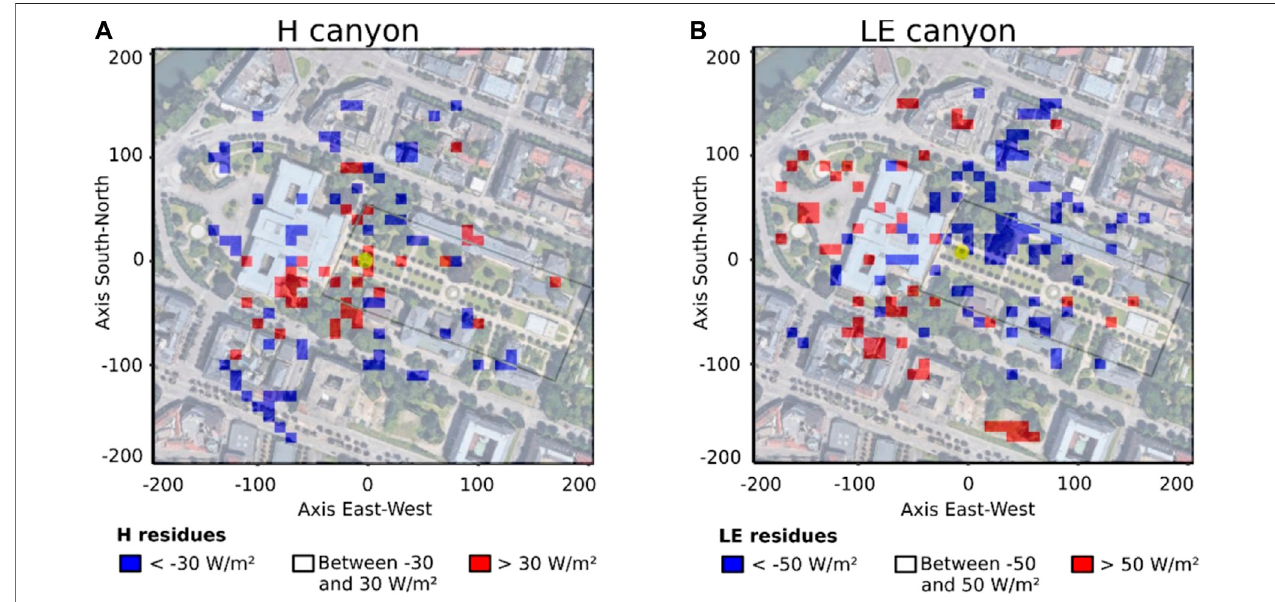
FIGURE 8 | Spatial distribution of the residues for (A) H and (B) LE fl uxes. The area considered by the model is indicated by the grey rectangle and the measurement mast by the yellow dot.